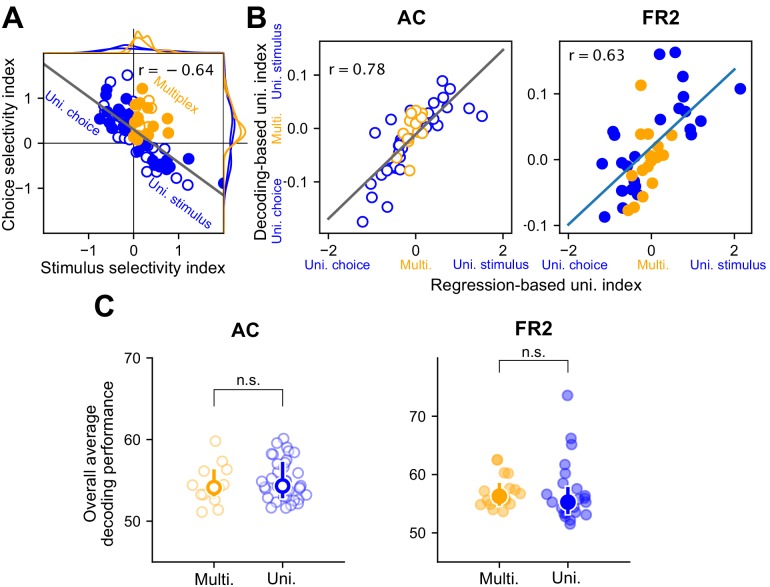
Decoding performance is a sufficient measure of uni/multiplexing.Given the correlation between stimulus category and behavioral choice we used a regression based analysis to determine whether decoding performance alone was sufficient to establish whether cells were multiplexed for both behavioral variables. We used multiple regression to create an alternative definition of multiplexing and uniplexing and then demonstrated this definition coincides with the one used in the paper based solely on decoding performance. (A) Choice selectivity index versus stimulus selectivity index for single cells. Each index quantifies the extent to which the corresponding variable was predictive of decoding performance. Multiplexed cells (orange symbols) have positive values on both indices. Uniplexed cells (blue symbols) are only positive for one of the two indices. Each cell was projected on the linear regression (grey line) to construct a regression-based uniplexing index. Multiplexed cells were close to zero on this measure and cells uniplexed for stimulus or choice were positive or negative, respectively. (B) The decoding-based uniplexing index (difference between stimulus and choice decoding performance) versus the regression-based index defined in a for AC (left, open symbols) and FR2 (right, filled symbols). In both regions, these two measures of uni/multiplexing were correlated. (C) Overall decoding performance (average of stimulus and choice decoding) for multiplexed cells versus uniplexed cells in AC (left) and FR2 (right). There were no systematic differences in decoding performance between multiplexed and uniplexed units (n.s. pAC = 0.22, pFR2 = 0.11, Mann-Whitney U test, two-sided).